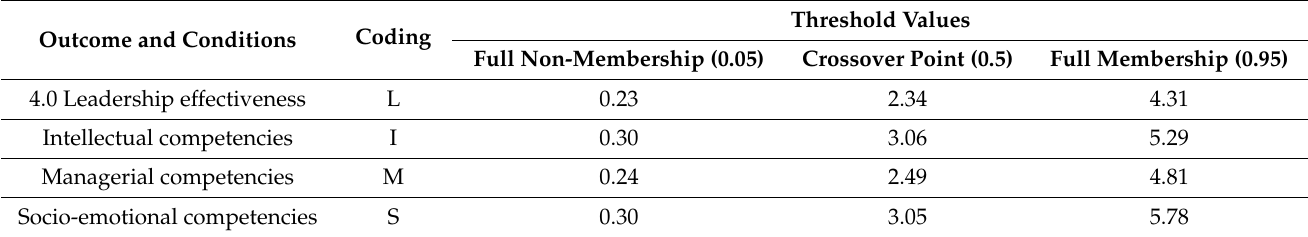
Table 3. Calibration of outcome and conditions into fuzzy sets. Source: own